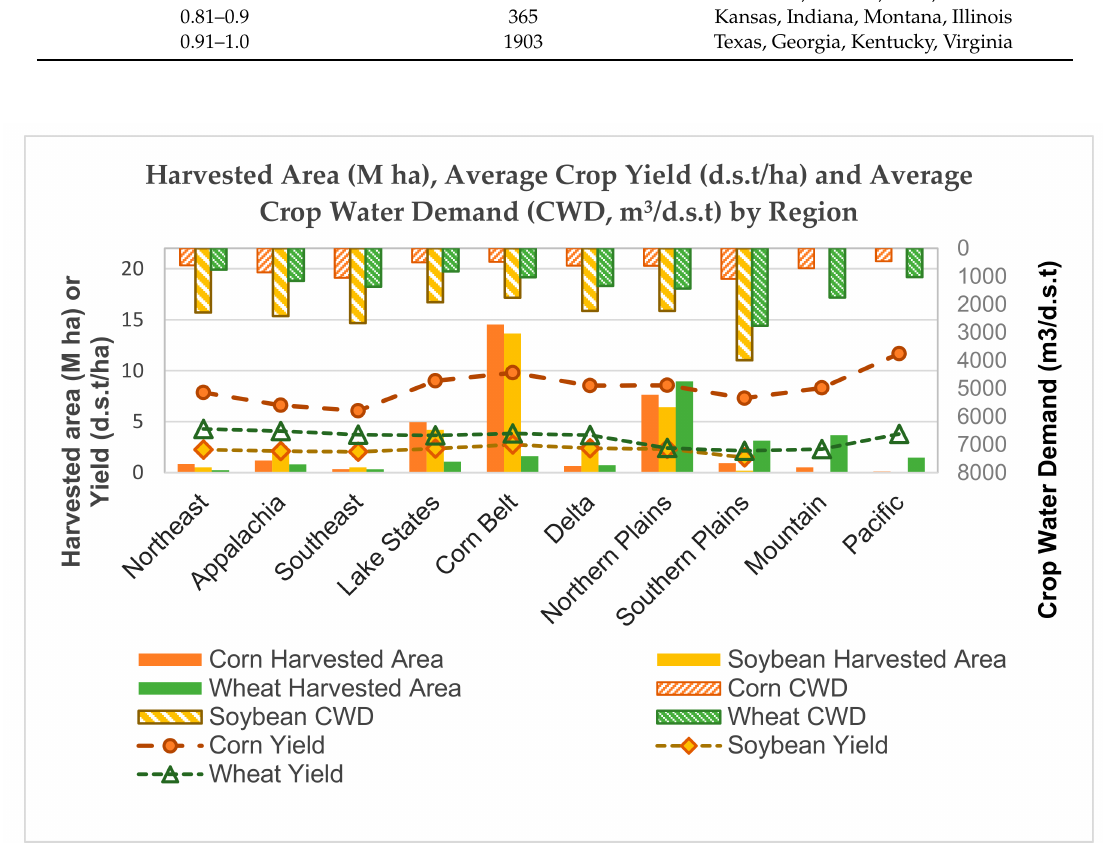
Figure 7. Regional crop production summary. Solid columns, dashed lines, and hatched columns show harvested crop area, average crop yield, and average crop water demand by crop by region, respectively. Harvested crop area and yields are based on 2008 county-level data reported by the USDA